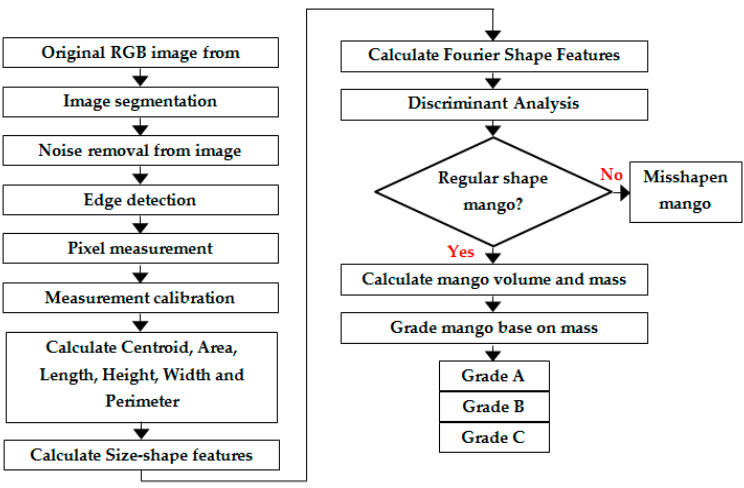
Figure 2. The methodology involved in this research.